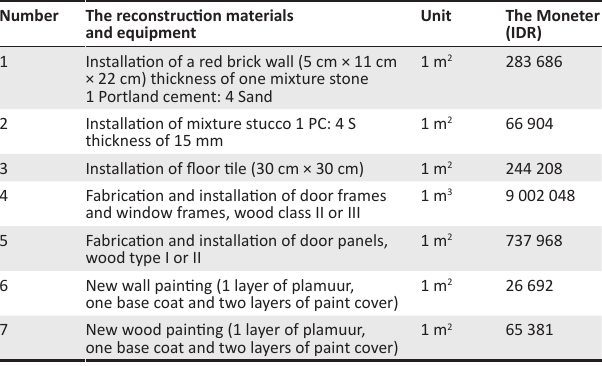
TABLE 1: The monetary values of reconstruction materials and equipment for